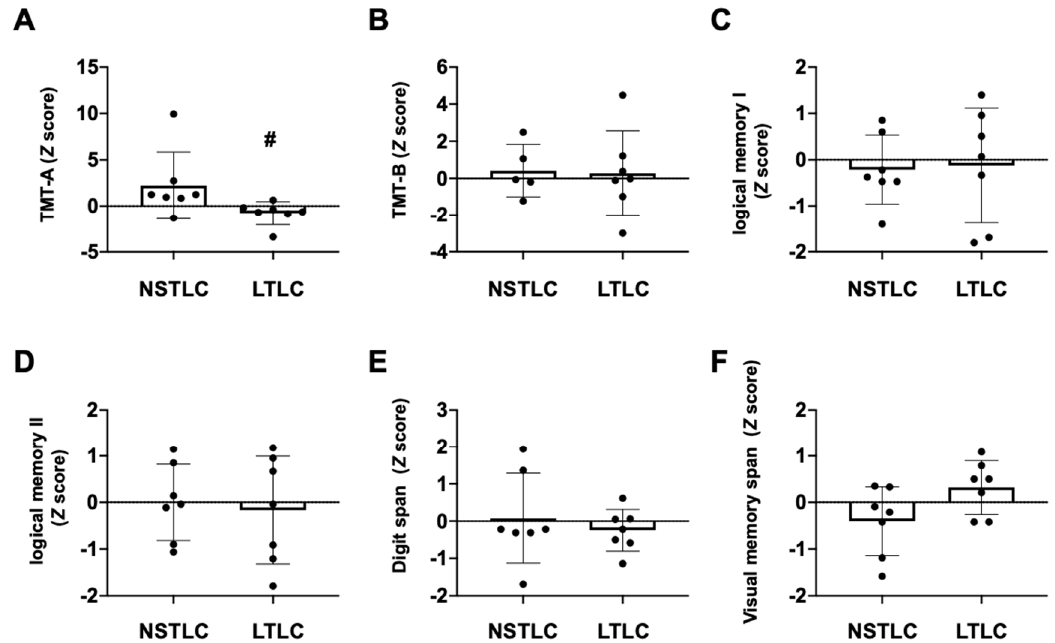
Figure 2. Comparison of neuropsychological tests between patients treated with NSTLC and with LTLC. Dot plots showing Z (standard score) of TMT-A ( A ), TMT-B ( B ), subsets of WMS-R logical memory I ( C )/II ( D ), digit span ( E ), and visual span ( F ) between hemodialysis patients treated with NSTLC and with LTLC. The Mann–Whitney test was used for comparison. Z (Standard score) = x (raw score) − µ (mean score)/ σ (standard deviation); # p < 0.05. LTLC, long-term L -carnitine treatment; NSTLC, no or short-term L -carnitine treatment; TMT = trail making test.